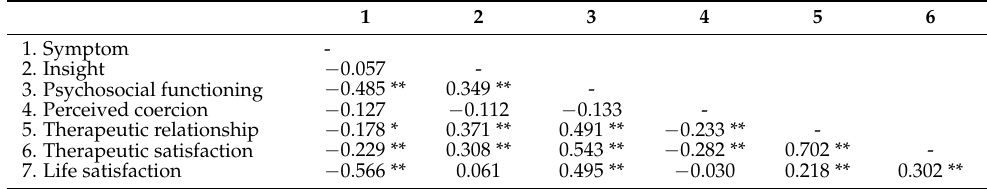
Table 2. Correlations among variables and perceived coercion.